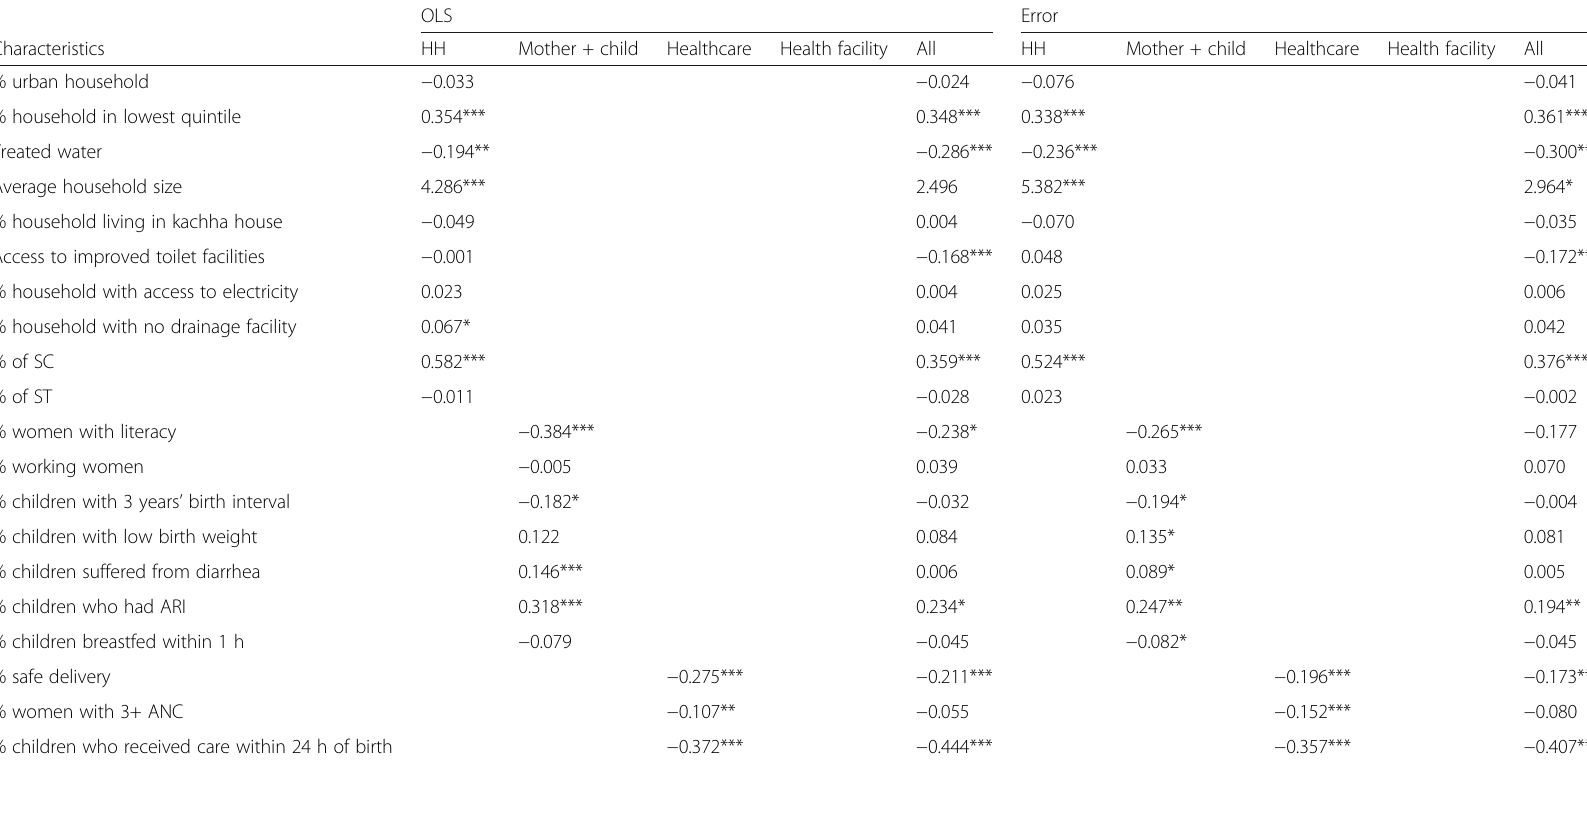
Table 2 Result of OLS model and spatial error model assessing determinants of IMR, High Focus States, 2010 – 2011